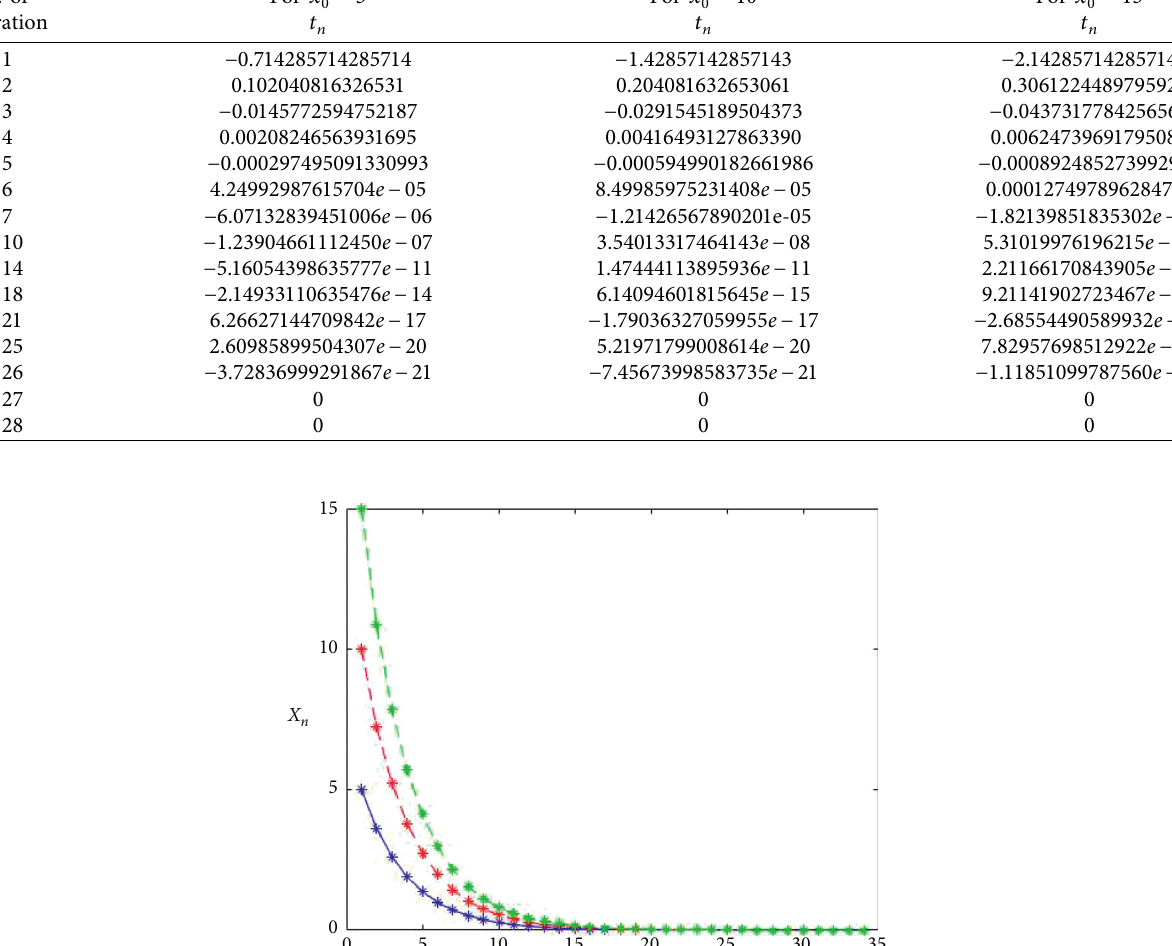
n with initial values